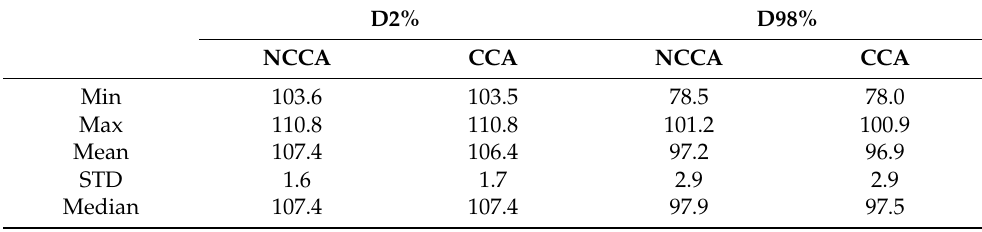
Table 7. Statistical analysis results for all nasopharyngeal cancer patients’ plans; statistically signifi- cant differences between NCCT- and CCT-based plans were found even though these differences are within ±